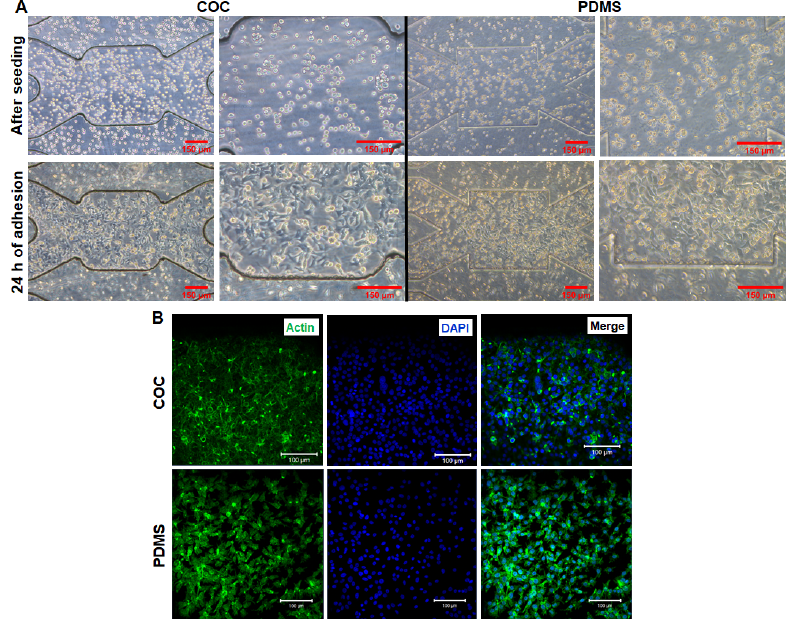
Figure 5. Characterization of HepG2/C3a cells adhesion on COC and PDMS biochips: ( A ) cell morphology after seeding and after 24 h of adhesion (scale bar 150 µ m), ( B ) Phalloidin and DAPI stainings of cells after adhesion phase: DAPI (nuclei, blue) and phalloidin (F-actin, green); scale bar 100 µ